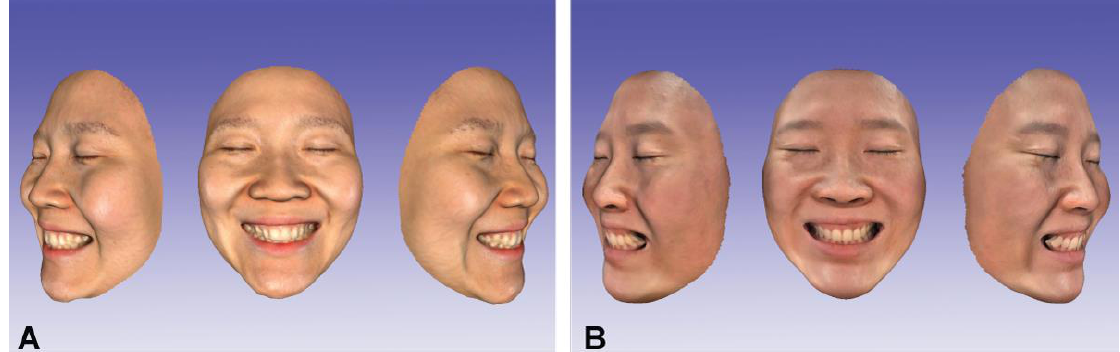
Figure 1. Three-dimensional face scans of the face with anterior teeth in broad smile (e phoneme) with different face-scanning systems. ( A ) Stereophotogrammetry; ( B ) smartphone depth sensor camera.